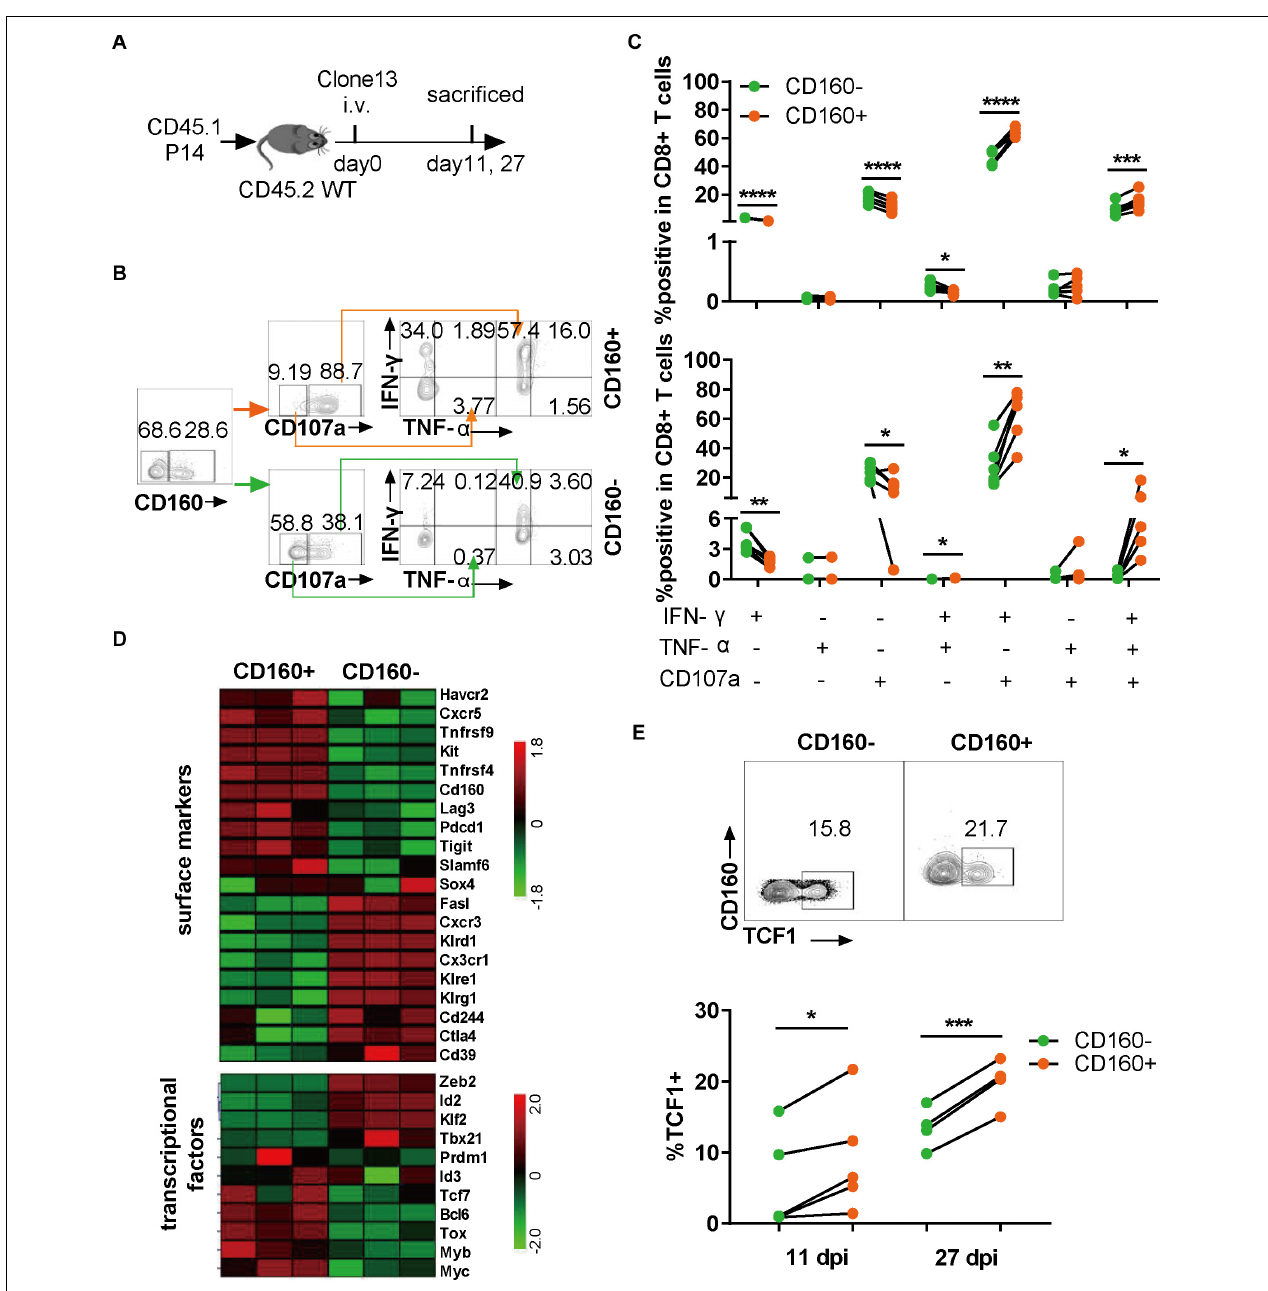
FIGURE 3 | CD160 marked a highly poly-functional CD8+ T cell subset with proliferative potential during chronic lymphocytic choriomeningitis virus (LCMV) infection in mice. (A) Schematic diagram of using adoptive P14 CD8+ T cell transfer to study the CD160 effect in chronic LCMV infection of mouse. A total of 10 4 of WT (CD45.1+) P14 CD8+ T cells were adoptively transferred into congenic (CD45.1–CD45.2+) naive recipient mice, which were subsequently infected with LCMV Clone 13. (B) Representative flow cytometric plots of gating strategy for analyzing the response of P14 cells isolated on 27 dpi to stimulation with GP33 peptide. (C) Comparison of magnitude and quality of responses of paired CD160– and CD160+ P14 T cells to GP33 peptide stimulation. The cells were analyzed on 11 dpi (C) , upper panel) or on 27 dpi (C) , lower panel). (D) Cell surface markers and transcriptional factors differentially expressed in LCMV-specific CD160– and CD160+ wild-type T cells as revealed by transcriptome profiling. CD8+ T cells from wild-type mice infected with LCMV Clone 13 for 7 days were stained with a mix of H-2D b tetramer presenting LCMV-specific peptide (GP 33 − 41 , GP 276 − 286 , and NP 396 − 404 ) and tetramer+CD160+ and CD160– T cells were sorted by flow cytometry for extracting RNA to perform microarray-based transcriptome profiling. Shown is the heatmap of detected differences in transcript levels of the indicated genes between CD160+ and CD160-CD8+ T cells. (E) Detection of TCF1 expression by flow cytometry on adoptively transferred P14 cells. Shown in the upper and the lower panels are representative flow cytometric plots (11 dpi) and pooled data of frequencies of TCF1-expressing cells, respectively. The experiments were independently repeated three times with n = 4–6 mice per experimental group. The data in (C,E) are analyzed by paired t test. * P < 0.05; ** P < 0.01; *** P < 0.001; **** P <